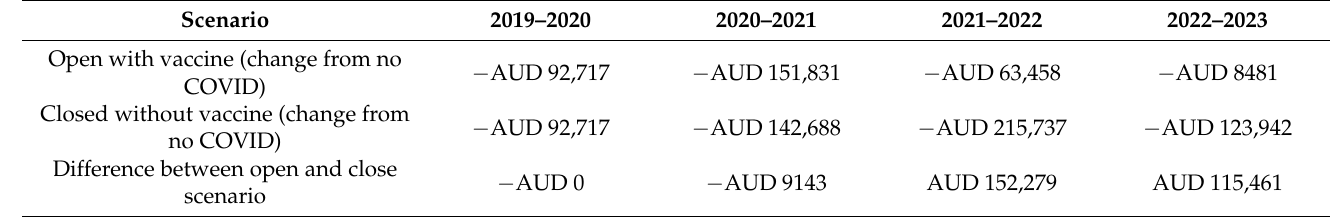
Table 2. Estimated impact on Commonwealth Government budget (AUD m, revenues less